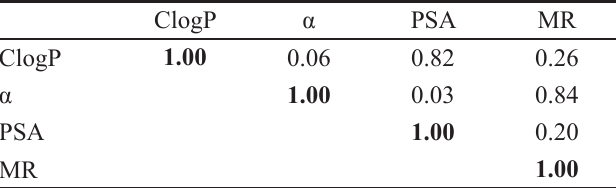
ClogP = calculated n -octanol/water partition coefficient; PSA = polar surface area; α = polarizability; MR = molar